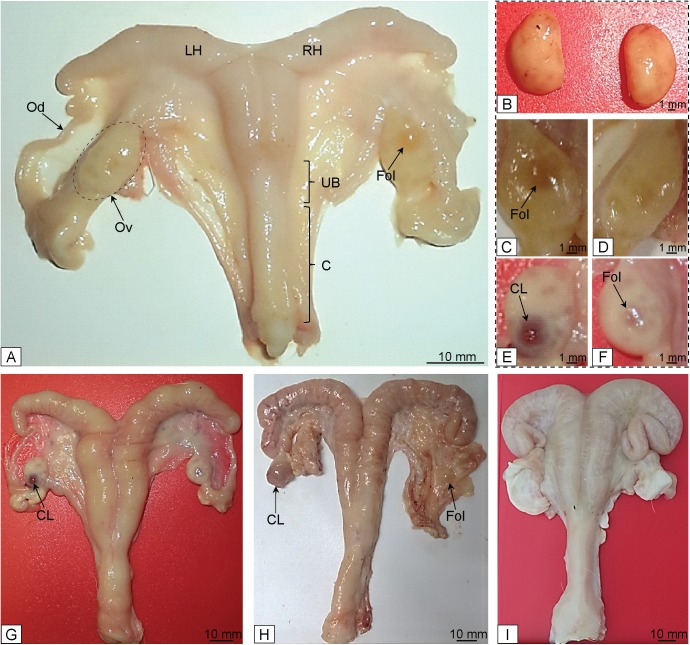
Characteristics of female white-tailed deer reproductive tract.(A) Fawns reproductive tract illustrating the ovary (Ov), oviduct (Od), left and right uterine horns (LH and RH, respectively), uterine body (UB), cervix (C), and large antral follicle (Fol); (B) ovaries of a young fawn with very low antral follicle activity; (C and D) ovaries of a fawn with the presence of mature antral follicle; (E and F) ovaries of a doe with presence of corpus luteum (CL) and Fol; and (G, H, and I) reproductive tract of does.